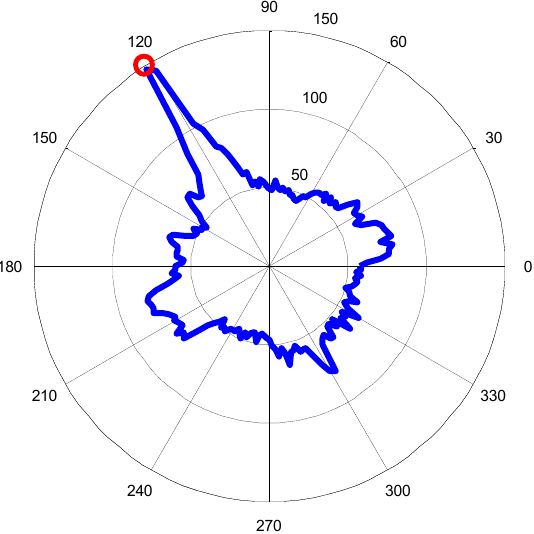
Figure 3. Maximum cross-correlation at the different rotation